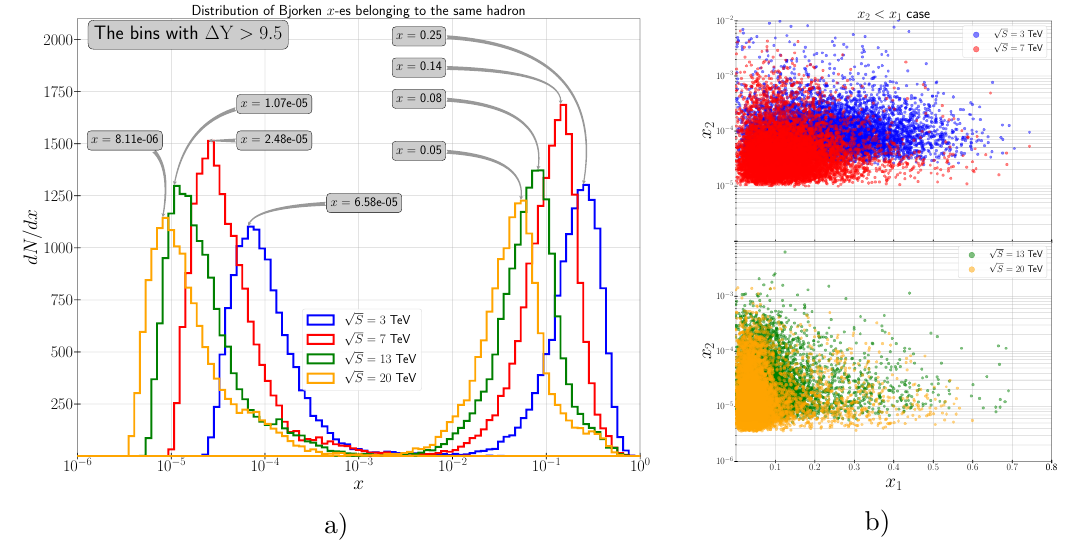
Figure 9 . Distribution of Bjorken x -es belonging to the same hadron for the bin with ∆Y ∈ [9 . 5 , 10] . Left plot: distribution of the minimal and maximal Bjorken x -es at 3, 7, 13 and 20 TeV collision energies. Right plot: distribution of the DPS events contributing to the ∆Y ∈ [9 . 5 , 10] bin in the x 1 - x 2 plane for the x 2 < x 1